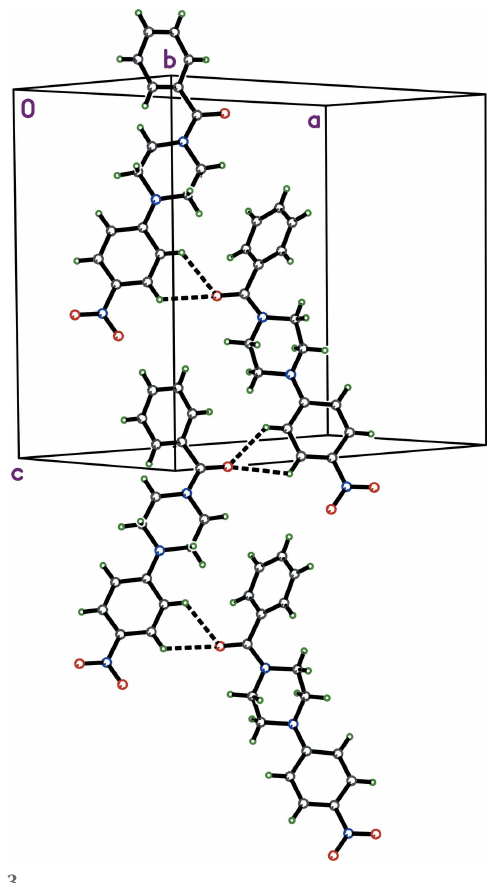
Figure 3 A partial packing plot of I , showing close contacts (dashed lines) that connect the molecules into chains parallel to the c -axis.